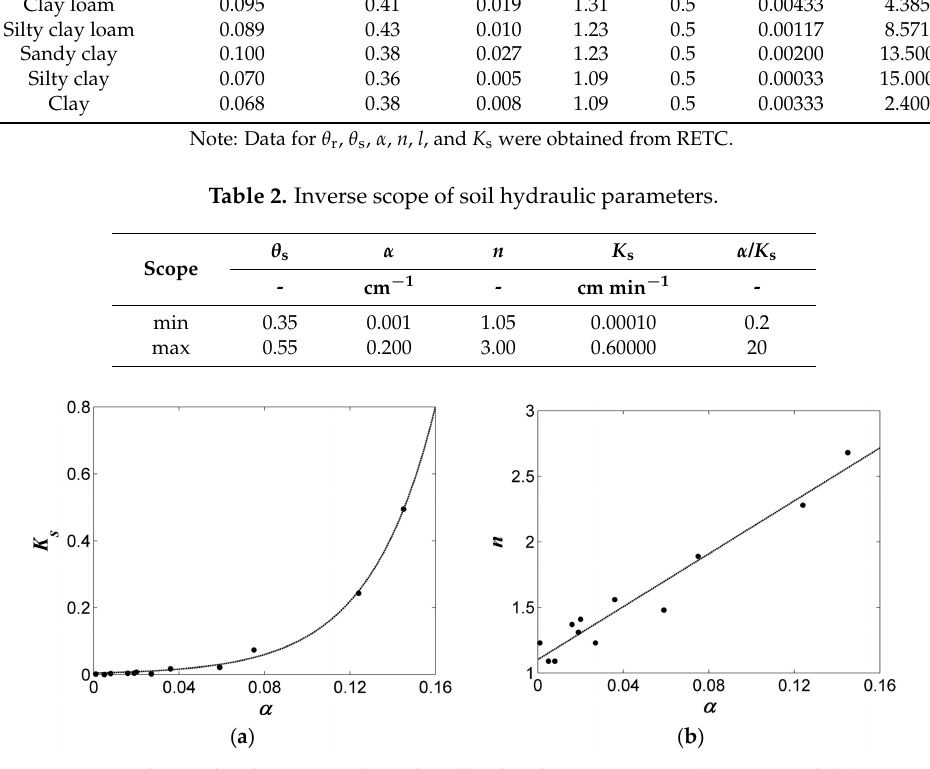
Figure 1. Relationship between selected soil hydraulic parameters: ( a ) α – K s ; and ( b ) α – n